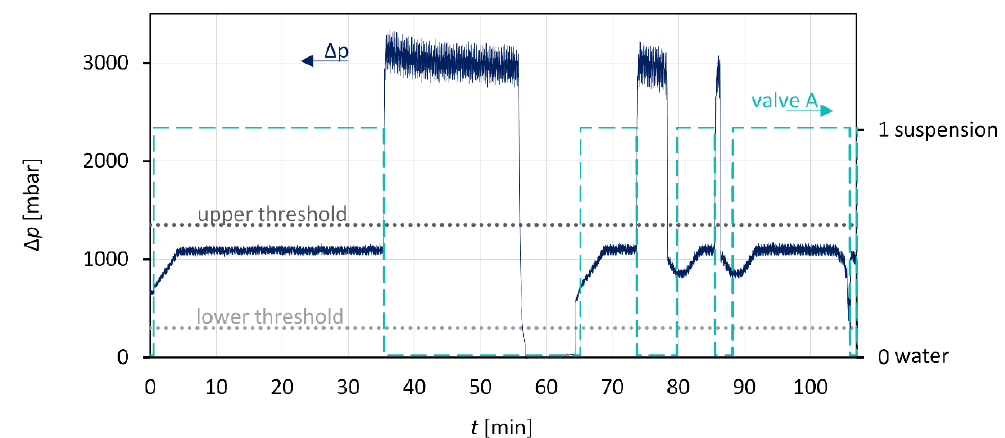
Figure 9. Pressure loss and magnetic valve position for “pressure loss rinsing” (for experiment seed 90-180 2).